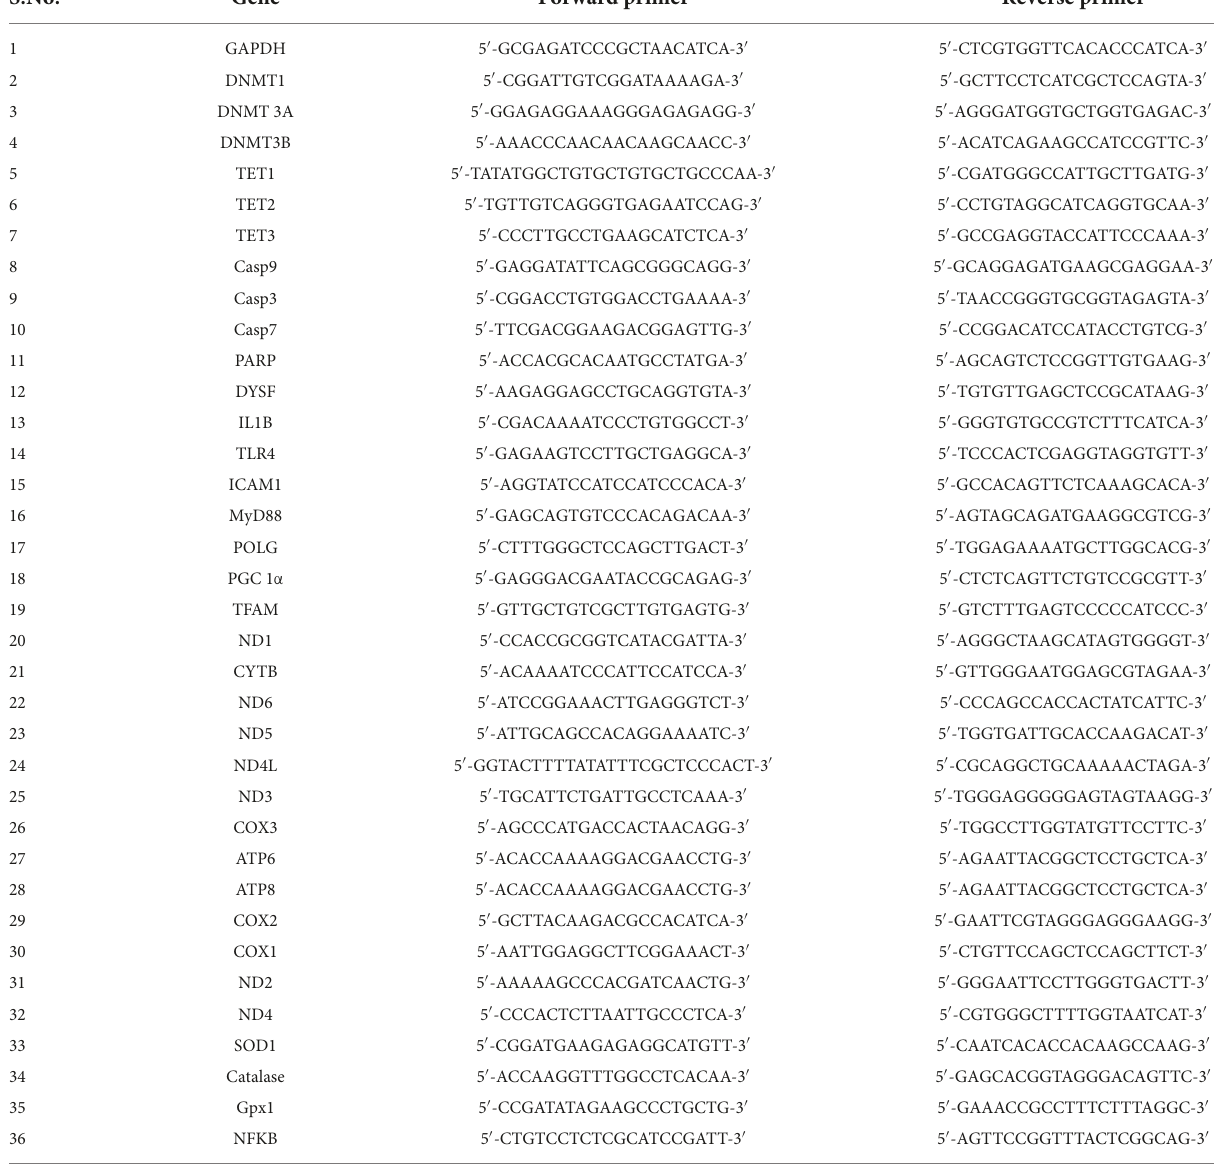
TABLE 1 Primer sequence details: The forward and reverse primer sequences of the genes used for real-time PCR analysis are presented. S.No.